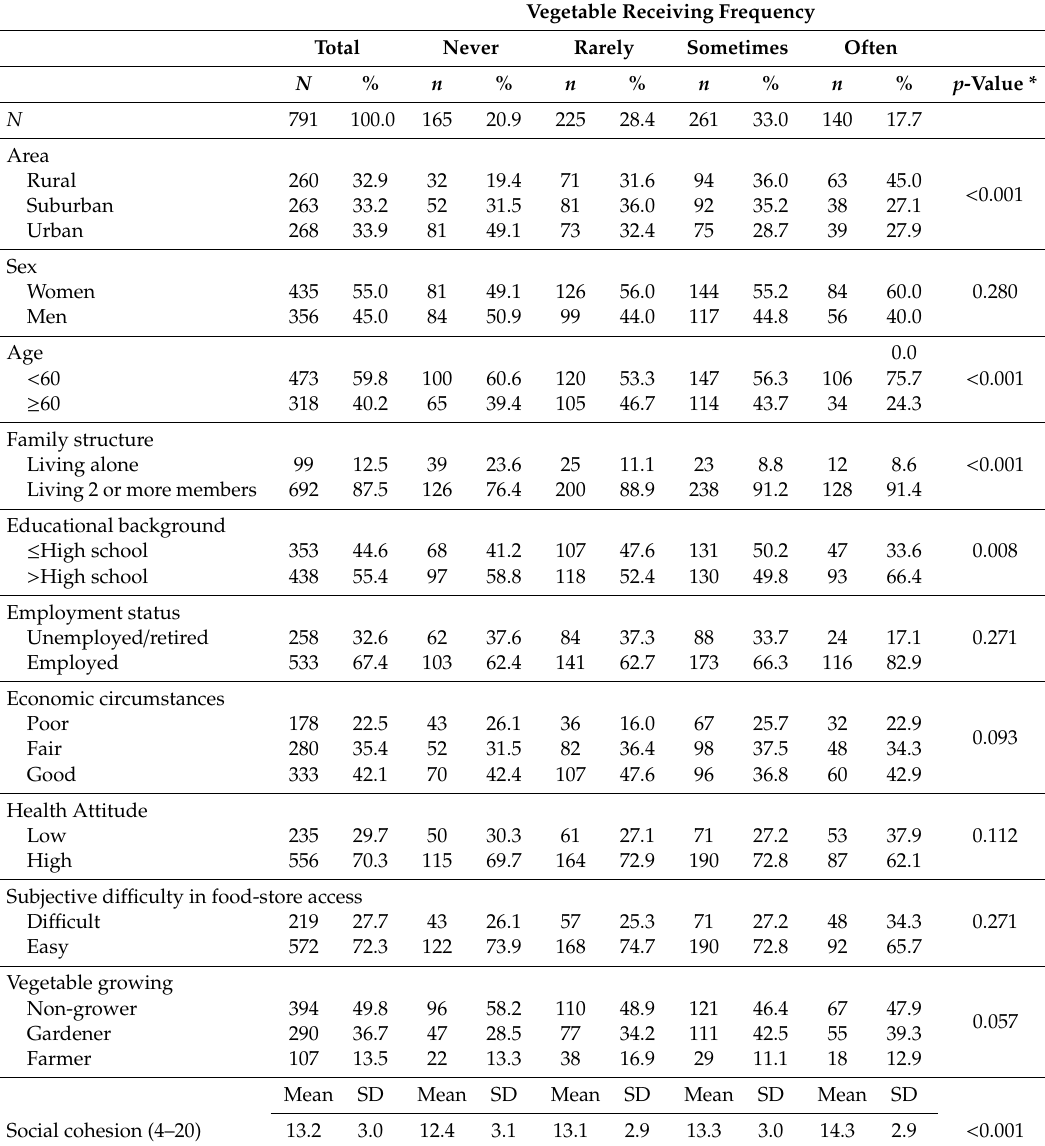
Table A2. Participants’ characteristics according to vegetable receiving frequency (Survey